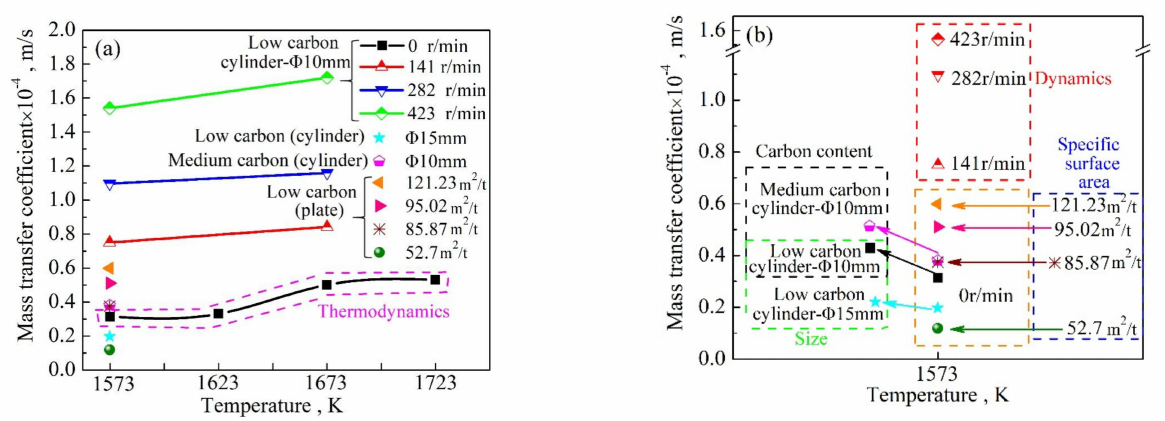
Figure 2. ( a ) Temperature dependence of the mass transfer coefficient under different experimental conditions ( b ) Magnified area of the graph in ( a